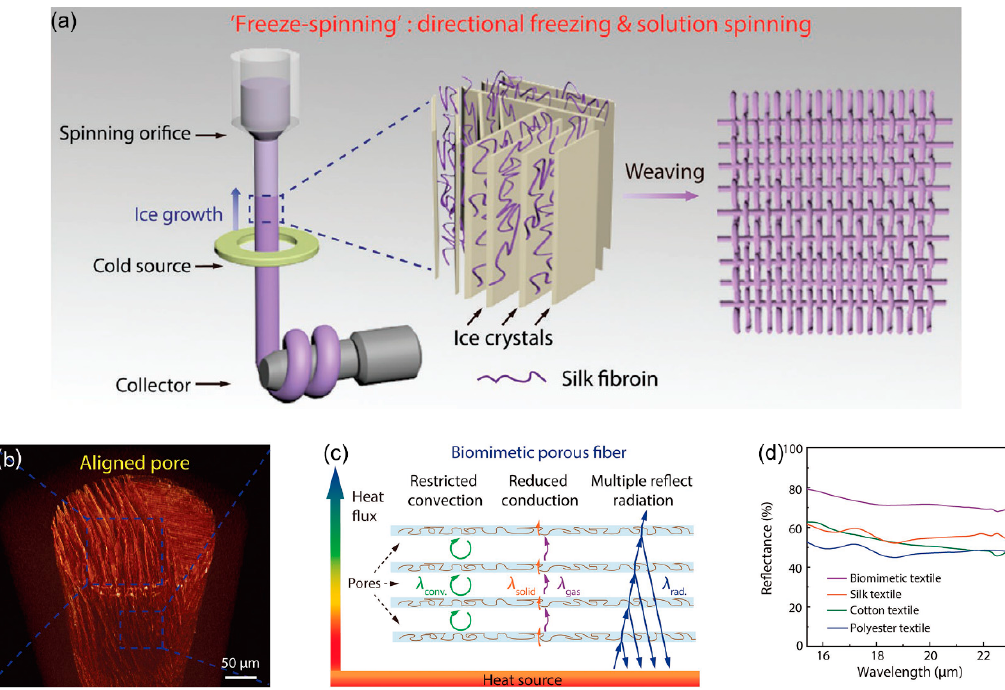
Figure 16. ( a ) Schematic illustration of the “freeze spinning” technique, combining “directional freezing” with “solution spinning” to realize continuous and large-scale fabrication of biomimetic fibers with aligned porous structure, mimicking polar bear hair. The silk fibroin solution extruded from a pump-controlled syringe is gradually frozen when it passes through a cold copper ring. Collected by a motor, the frozen fiber is further freeze-dried to reserve its porous structure and subsequently woven into a textile, ( b ) X-ray computed microtomography image showing the aligned lamellar pores within the biomimetic fiber along its axial direction, ( c ) schematic illustration of the thermal conductivity of the biomimetic porous fiber with aligned pores, and ( d ) infrared light reflectance measurement of different textiles with similar thicknesses ( ≈ 0.4 mm) performed using a Fourier transform infrared (FTIR) spectroscopy microscope: biomimetic, silk, cotton, and polyester textiles are compared. Reproduced from Ref. [131] with permission. Copyright 2018, John Wiley and Sons.